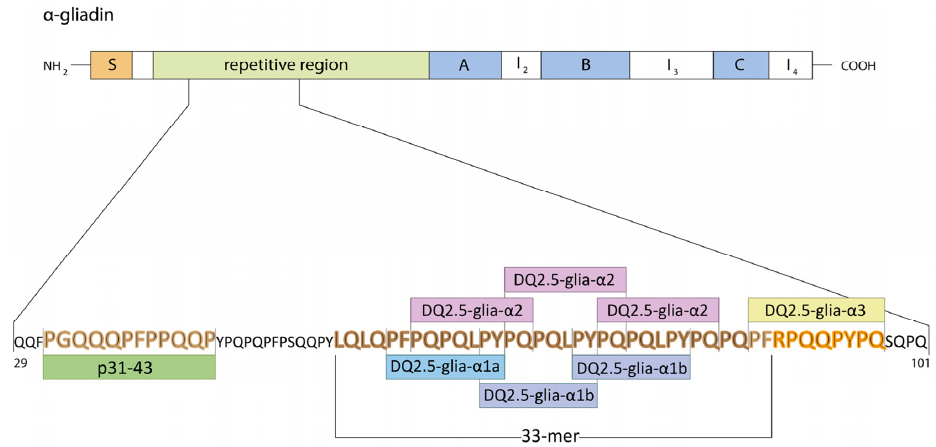
Figure 6. Fragment of α -gliadin protein sequence. Main immunogenic fragments: peptides p31-43, 33-mer and DQ2.5-glia- α 3 are indicated. Six epitopes of type 1 α‐ gliadin are DQ2.5 ‐ glia ‐α 1a/b and DQ2.5 ‐ glia ‐α 2 (Figure 6). There is also